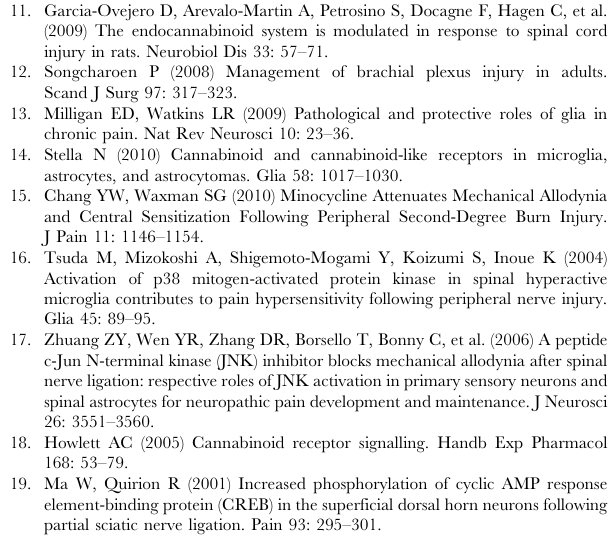
Table S1 Behavioral effects of cannabinoids agonists in the mouse tetrad